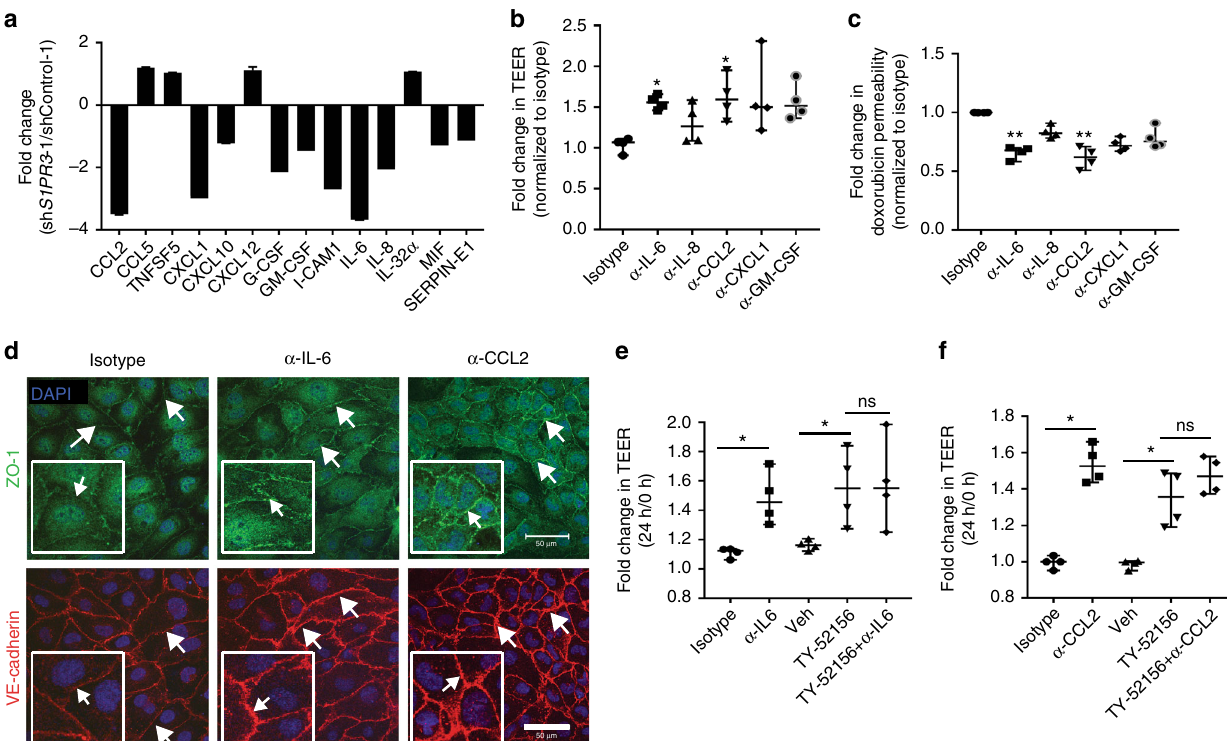
Fig. 8 Knockdown of S1PR3 in astrocytes reduced cytokine secretion and altered endothelial adhesion. Serum-free culture supernatant from shControl-1 and sh S1PR3 -1 astrocytes were compared for expression of 36 cytokines and chemokines using a commercial human cytokine array. a Mean spot pixel density was measured of quanti fi able spots with ImageJ and plotted which demonstrated a signi fi cant reduction in various cytokines (two spots for each cytokine). b The effect of neutralizing antibodies to cytokines on BBB permeability in vitro. See Fig. 5a for experimental schematic. Addition of neutralizing antibodies to IL-6, IL-8, CCL2, CXCL1, and GM-CSF increased TEER resistance as compared to an isotype-matched control antibody. Only anti-IL-6 and anti-CCL2 at 24 h showed a signi fi cant increase in TEER ( n = 4). c Neutralizing antibodies to cytokines decreased doxorubicin permeability. Permeability of 100 µ g mL − 1 doxorubicin from luminal to abluminal side of the inserts in the BBB was measured. Anti-IL-6 and anti-CCL2 decreased doxorubicin permeability signi fi cantly ( n = 4). d Staining of endothelial cells for ZO-1 (green) and VE-cadherin (red) in BBB cultures treated with neutralizing antibodies. Nuclei were DAPI stained (blue) (scale bar = 50 μ m). The effect of combined treatment of astrocytes with TY-52156 and anti-IL-6 antibody or anti-CCL2 antibody on TEER. There was no signi fi cant augmentation of resistance when IL-6 antibody ( e ) or CCL2 ( f ) antibody were included along with TY-52156 in BBB model ( n = 4). For panels ( b ), ( c ), ( e ), and ( f ), each point indicates median fold change, and the bars represent the overall median with the 95% con fi dence interval, for each BBB culture. Kruskal – Wallis test and Dunn ’ s multiple comparison test were performed. * P < 0.05, ** P < 0.01, ns